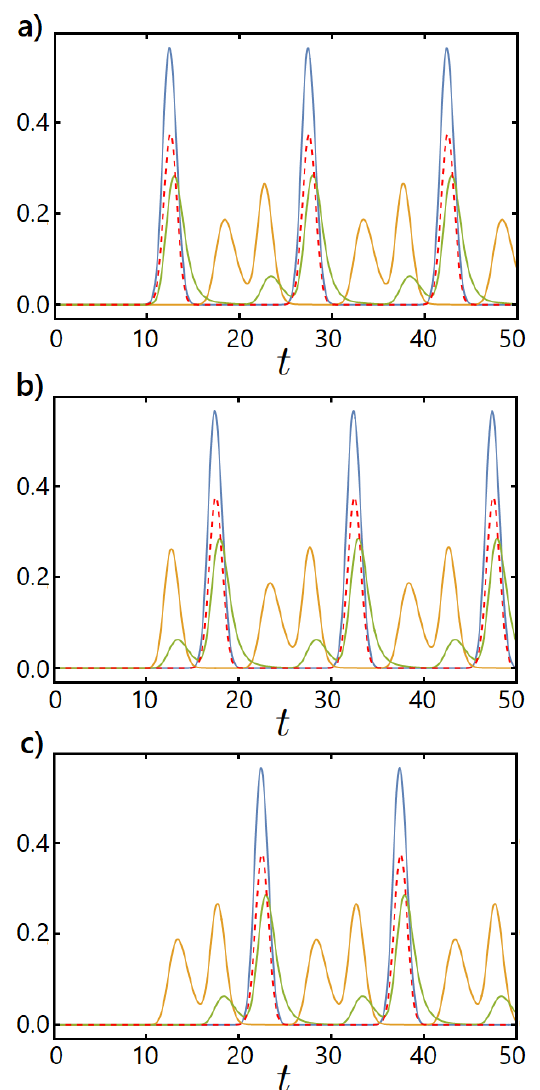
Figure 4: Same as panel a) of Fig. 2 but with different Γ (cid:96) riodic and shifted for each line. We show incoming flow (blue curve), outgoing flow (yellow curve), occupancy (green curve) and incoming coupling strength (dashed line) for site 1 (panel a), site 2 (panel b) and site 3 (panel